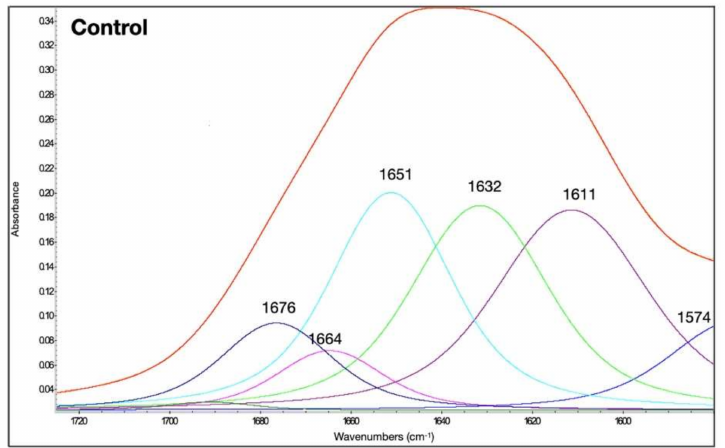
Figure 1. Amide I band of the native gluten control without temperature (25 ◦ C) and the additive treatments. The secondary structure determination by the curve-fitting procedure is indicated.